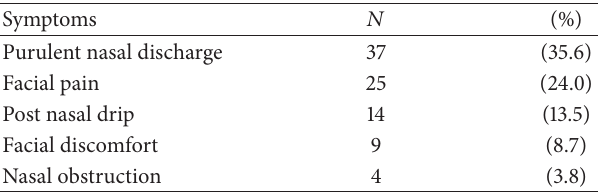
Table 5: Culture study of fungus